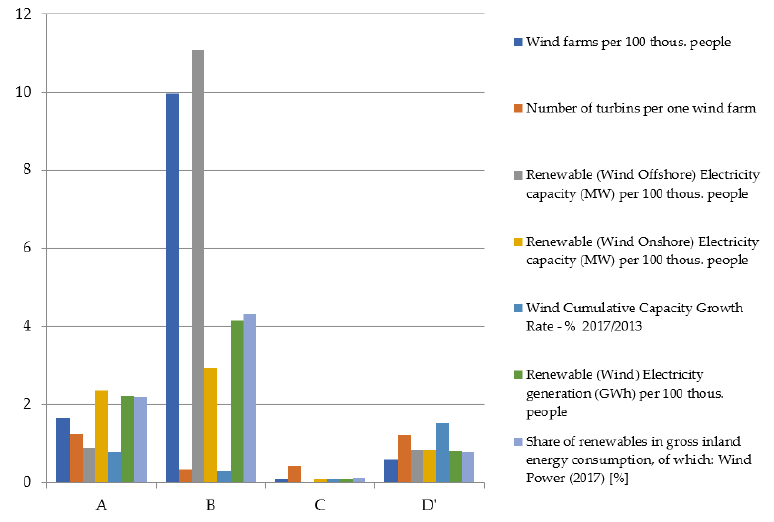
Figure 7. Group means for the 4 clusters formed.